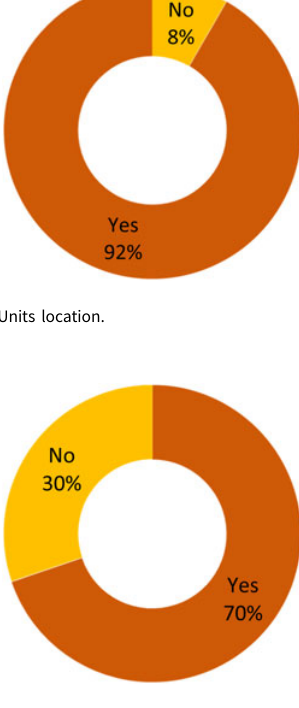
Fig. 3. Use of services provided by the Unit.